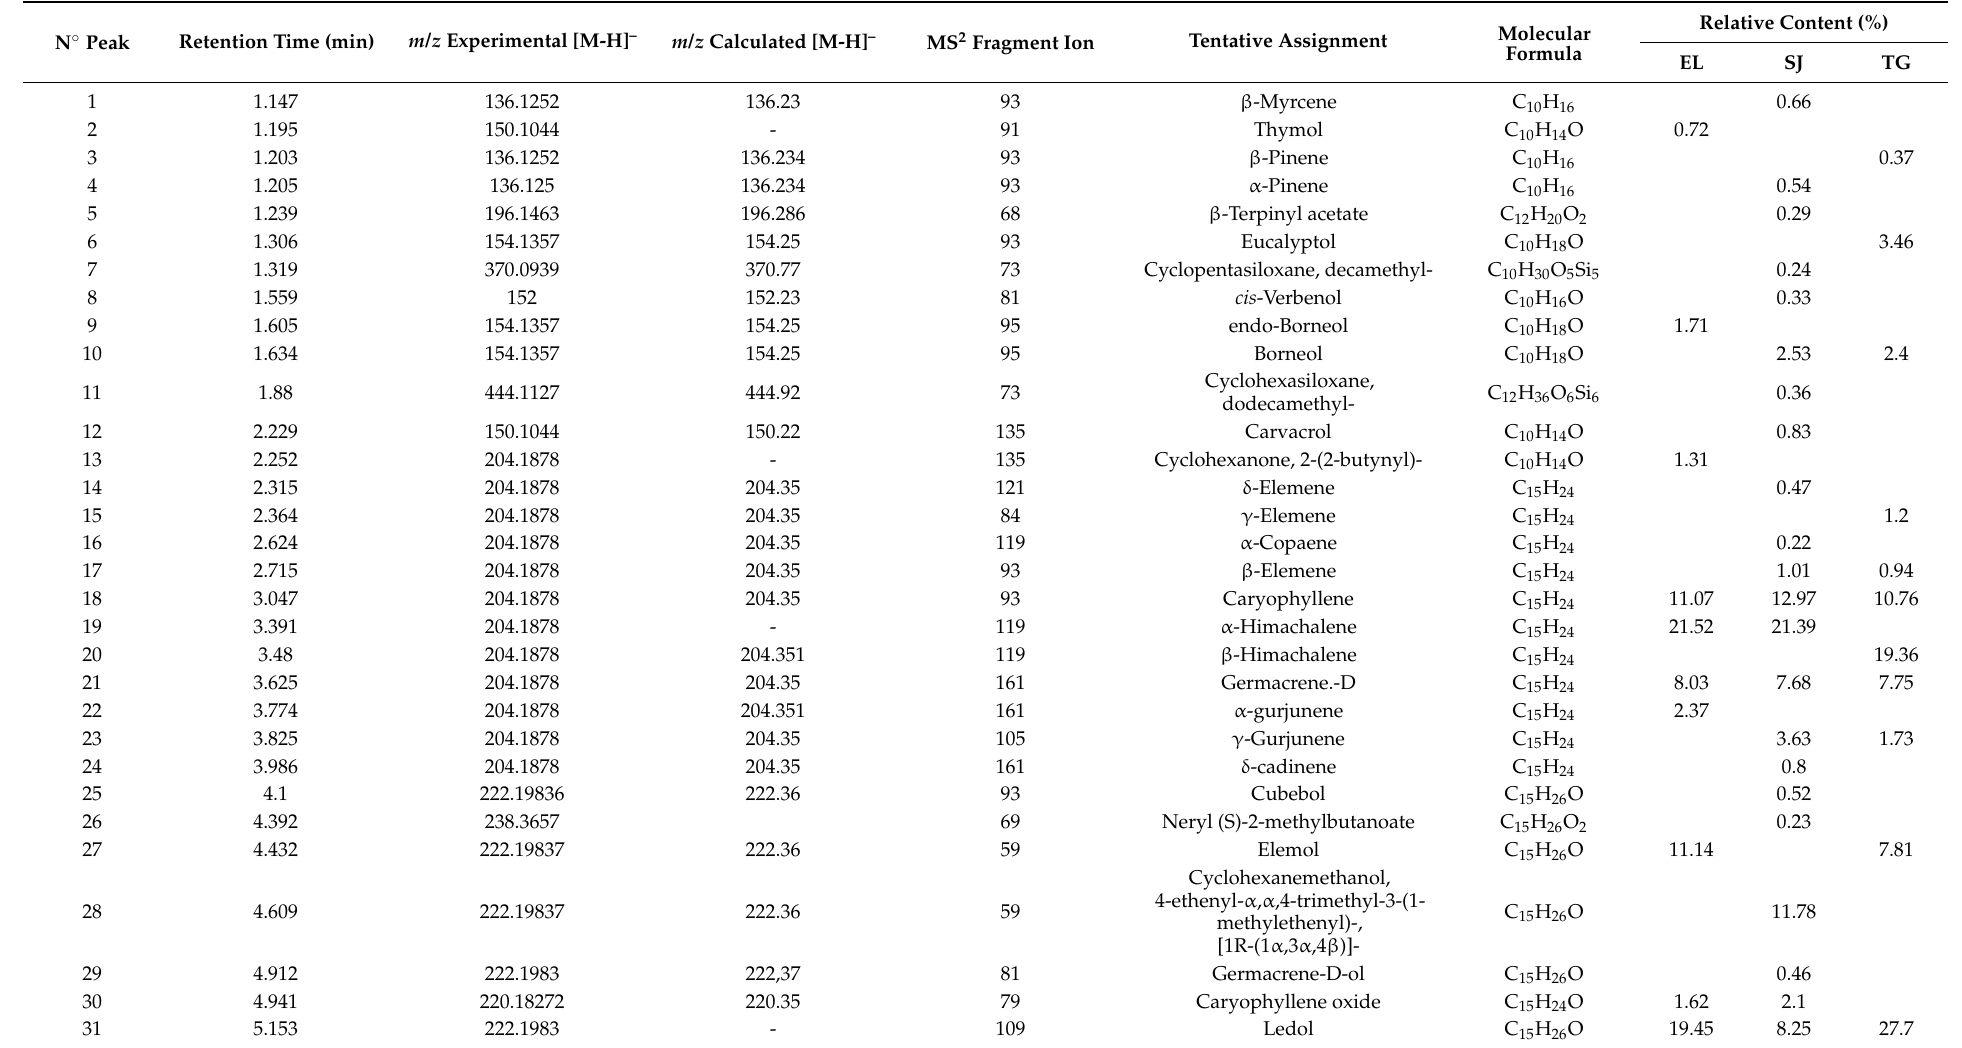
Table 3. Identification of essential oil compounds of F. cernua by